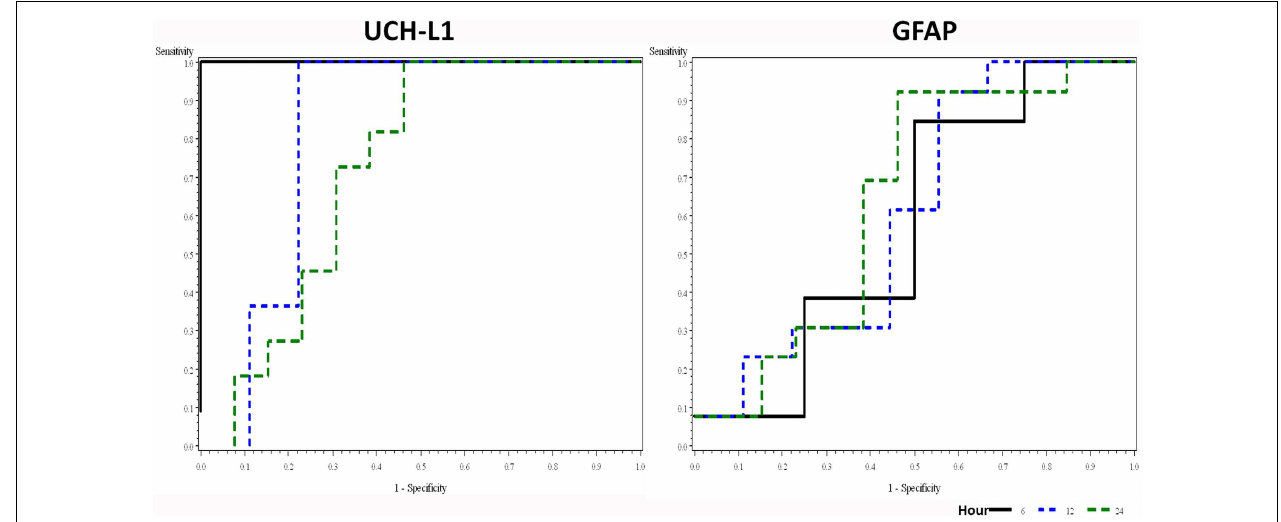
(0.51–0.94) for 0–6, 12, and 24h, respectively. AUC (95% CI) for GFAP is 0.58 (0.15–1.00), 0.61 (0.33–0.88), and 0.64 (0.41–0.87) for 0–6, 12, and 24h, respectively.